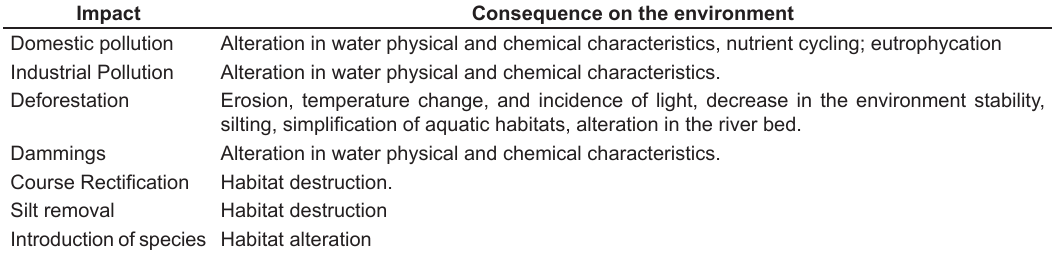
Table 1. Main impacts in the middle and lower courses of the Tietê River and their consequences to the river.